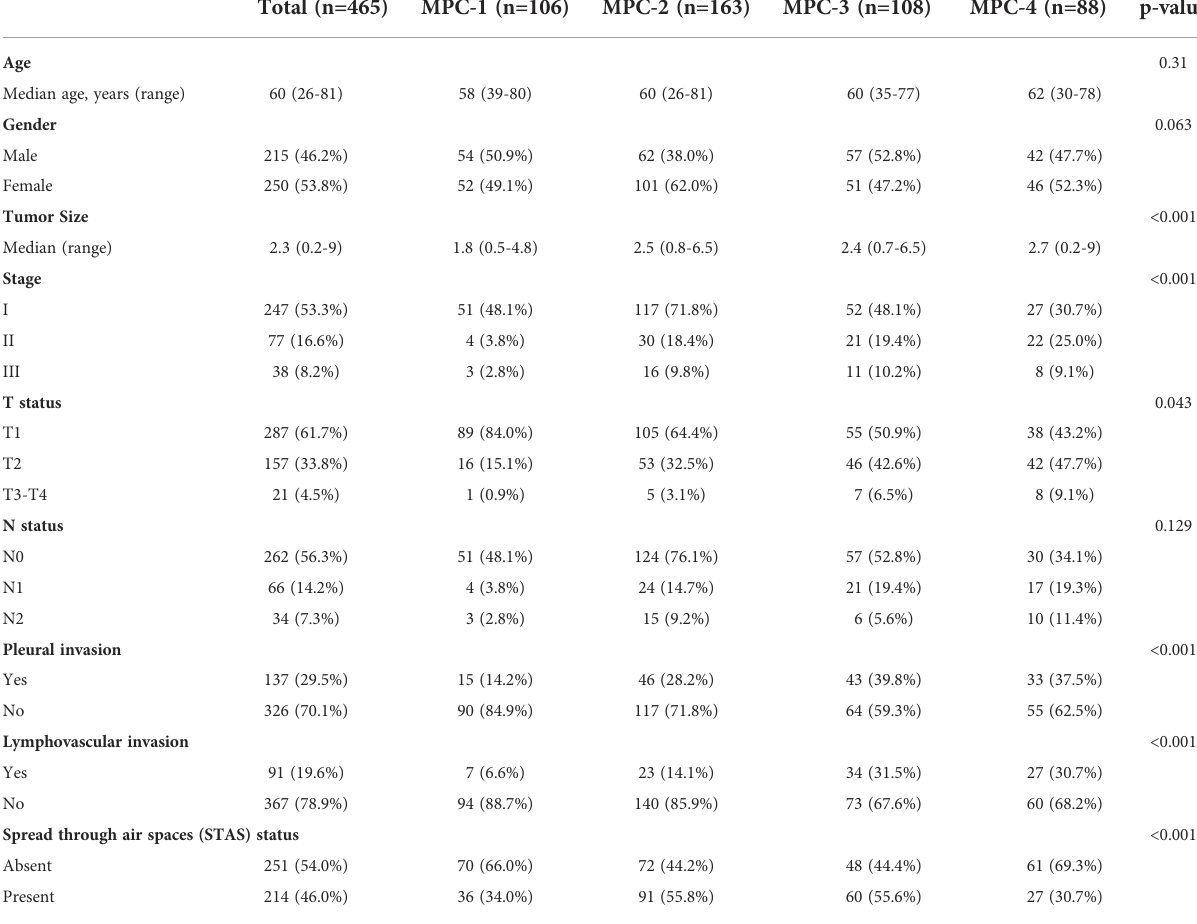
TABLE 1 Correlation analysis between different micropapillary content and clinicopathologic